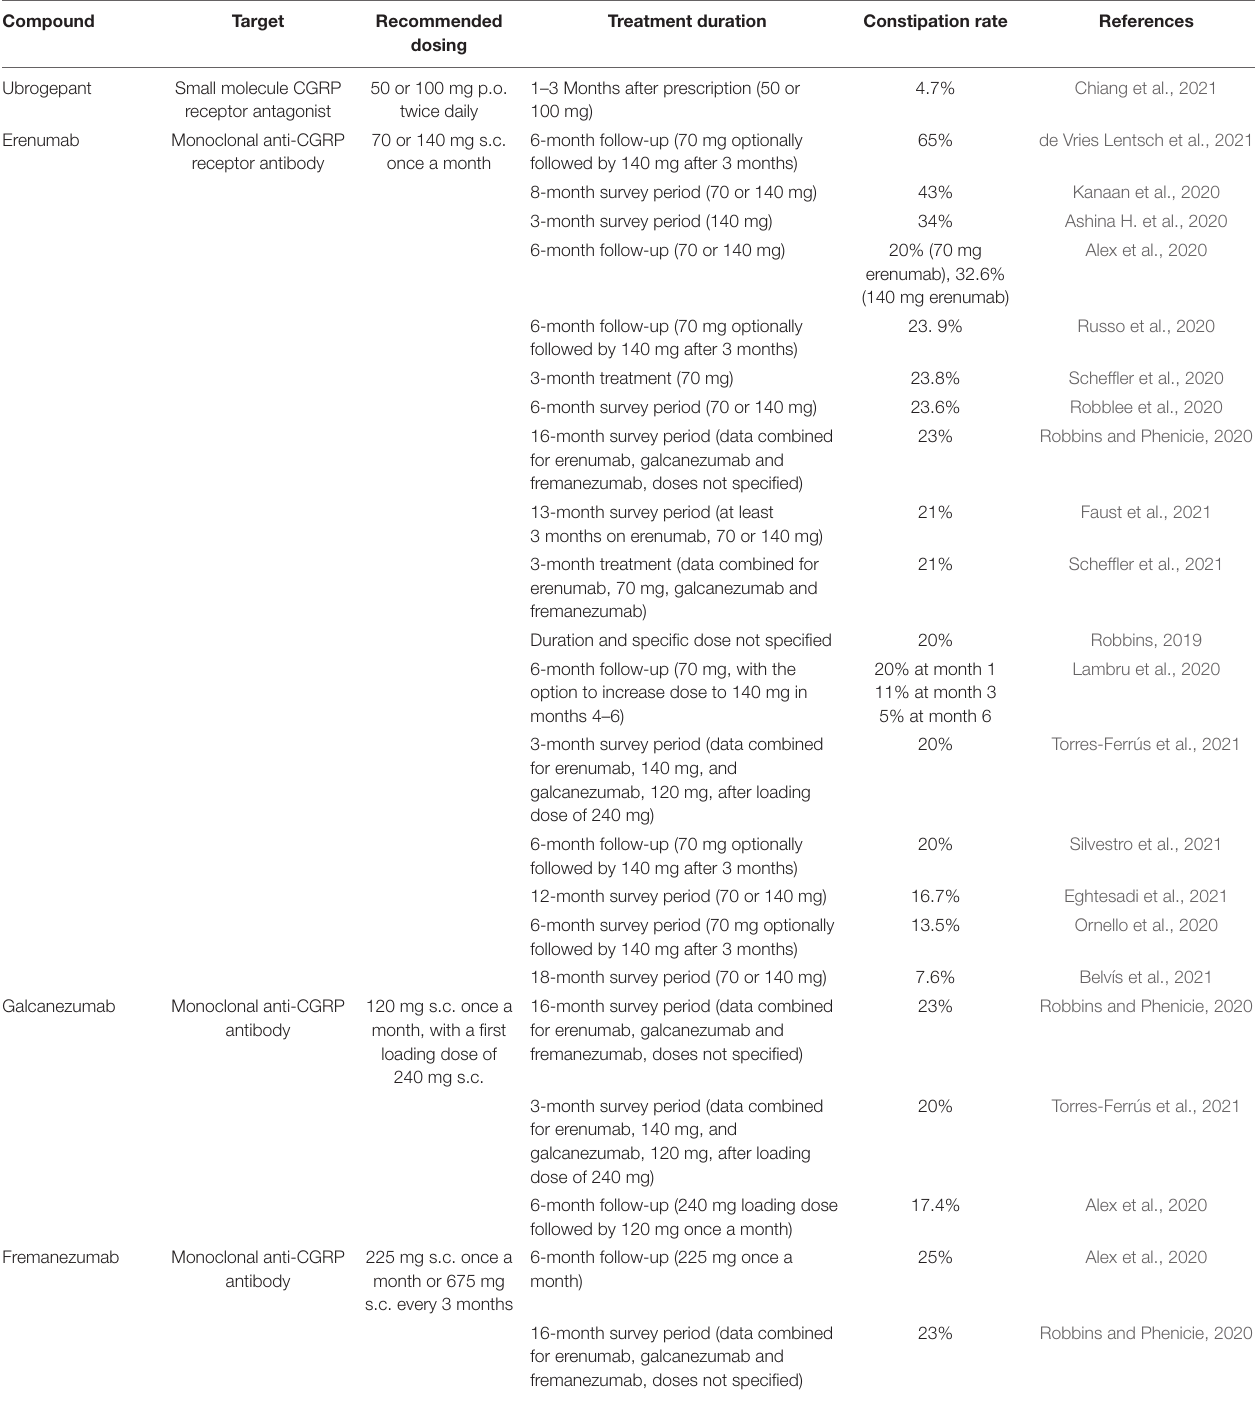
TABLE 1 | Constipation rates in migraine patients treated with CGRP receptor antagonists or monoclonal antibodies targeting CGRP or its receptor as reported in post-approval surveys (real-world evidence).